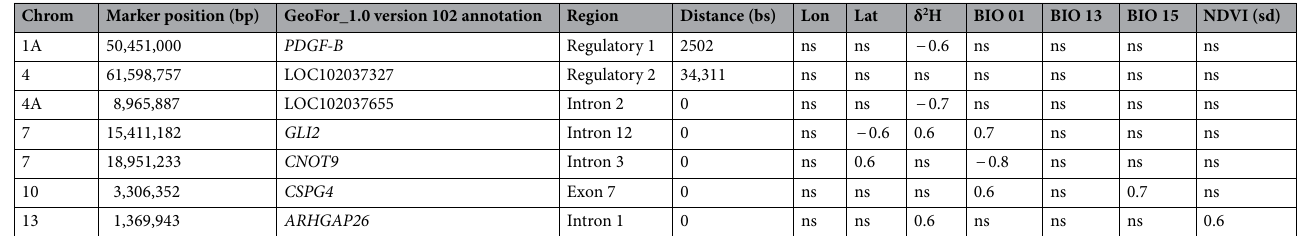
Table 3. Correlation of top candidate genes (allele frequencies) identified in FASTmrMLM and the bslmm model with Longitude, Latitude, hydrogen stable isotope, and the top ranked environmental variables identified in the gradient forest analyses (BIO01, BIO13, BIO15,